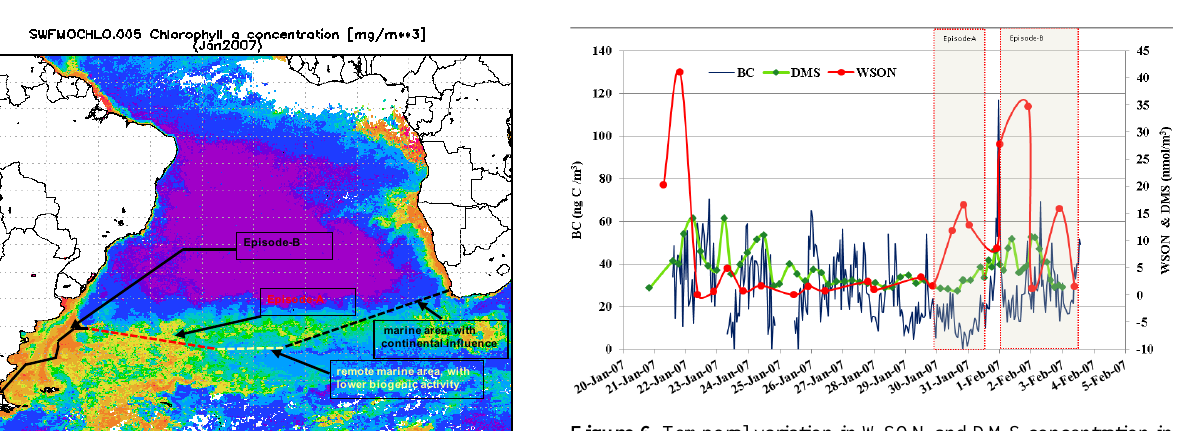
Figure 6. Temporal variation in WSON and DMS concentration in fine particles (PM 2 . 5 ) together with BC concentration during the cruise in South Atlantic atmosphere. The frames define the marine areas with intense biogenic activity (episodes A and